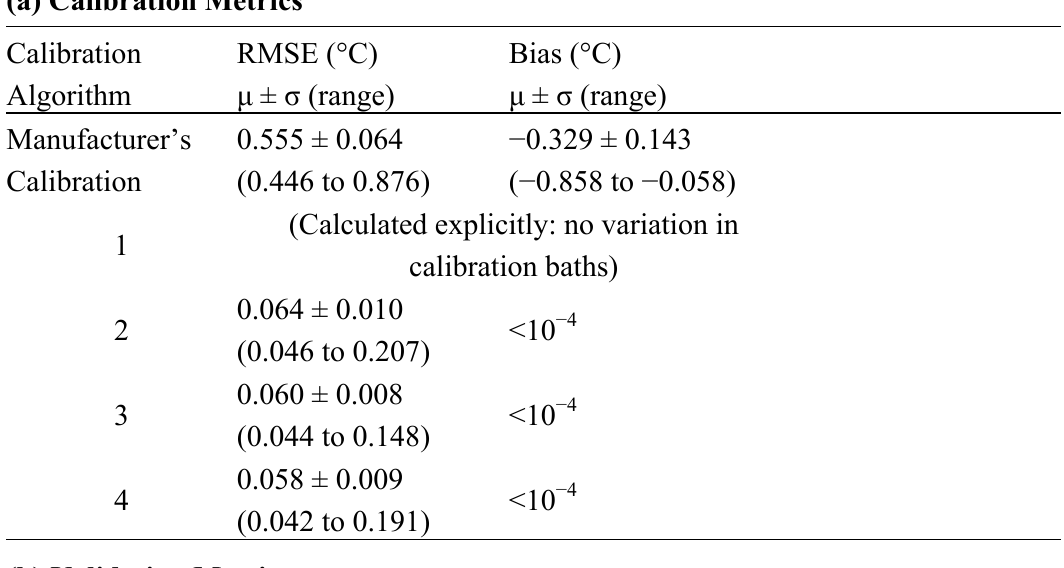
Table 3. Calibration metrics for the field deployment at Hacienda la Pacifica (n = 720, 1 m spatial sampling interval, 30 second integration times, 21 points in each reference and validation section). (a) Calibration metrics for the three calibration baths. (b) Calibration metrics for the validation bath. The sample algorithms were run on step-corrected data, while the manufacturer’s calibration reflects only the uncorrected